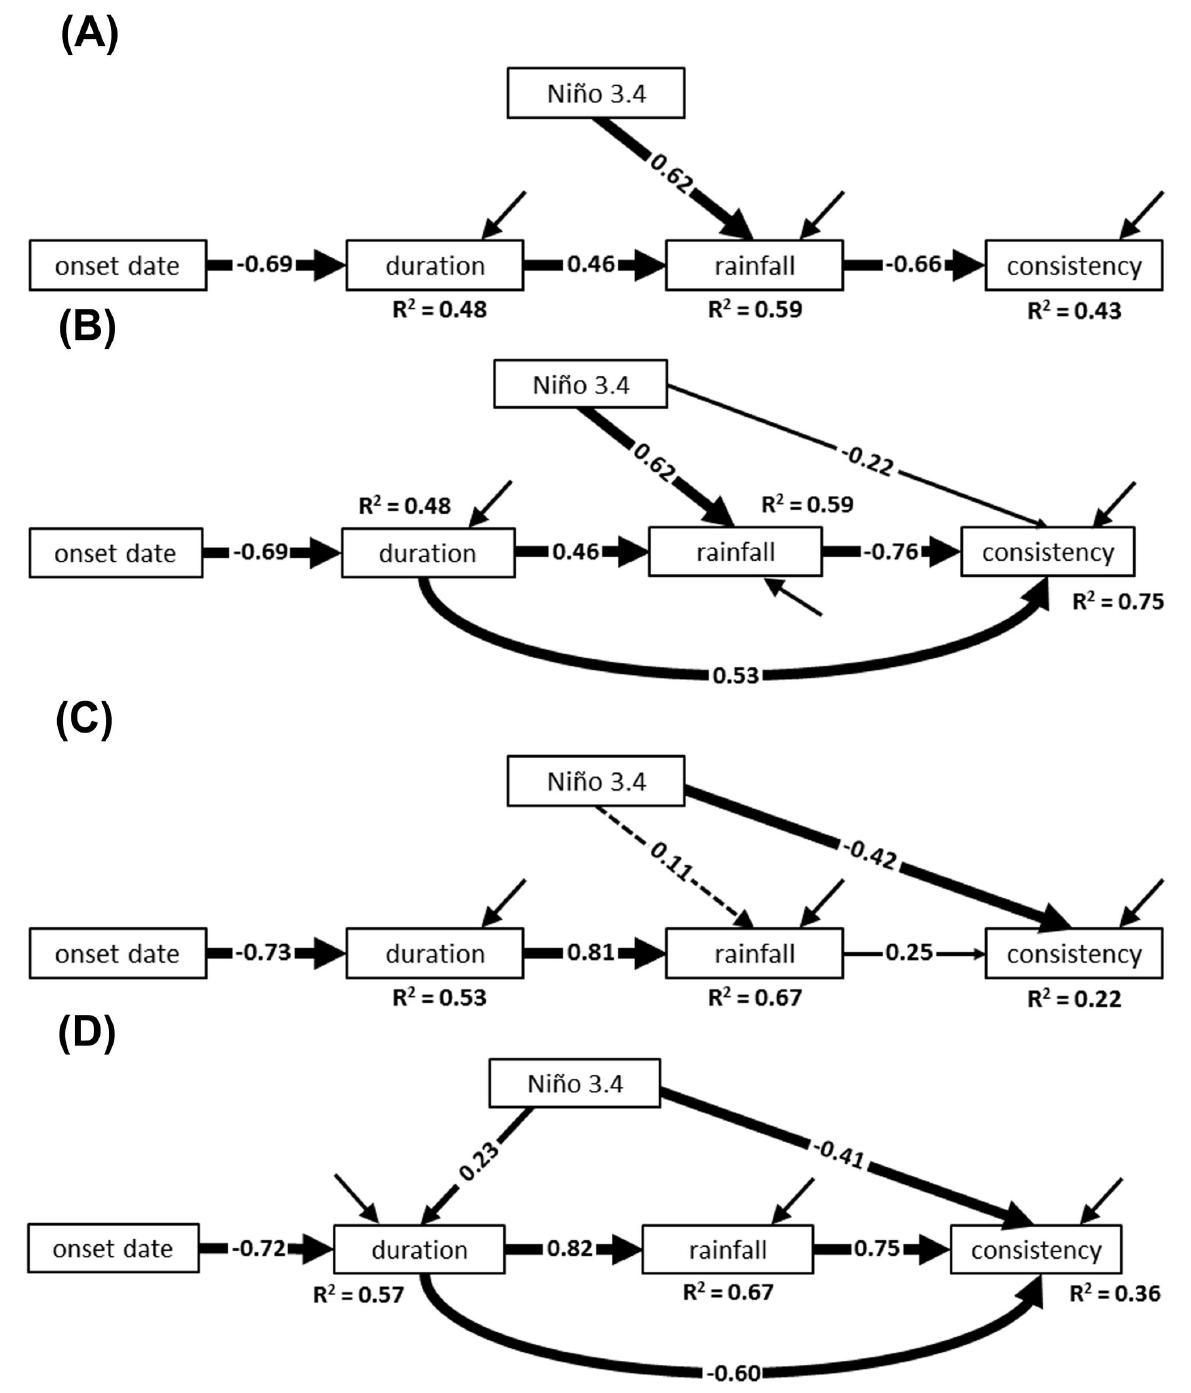
Figure 3. Structural equation models describing relationships among ENSO and seasonal characteristics for the two seasons. Models include (A) our starting, theory-driven model for the dry season (BCC = 65.6; χ 2 = 45.3, df = 6, p < 0.001), (B) the “best” exploratory model for the dry season according to BCC values (BCC = 39.7; χ 2 = 3.7, df = 4, p = 0.44), (C) our starting model for the wet season (BCC = 40.6; χ 2 = 18.2, df = 5, p = 0.003), and (D) the “best” model for the wet season (BCC = 28.8; χ 2 = 4.1, df = 4, p = 0.40). Paths are accompanied by numbers, which are standardized partial regression coefficients. The significance of these coefficients is shown with differently weighted lines (dashed = non-significant, thin = p ≤ 0.05, medium = p ≤ 0.01, and thick = p ≤ 0.001). Models use 58 years of climate data collected for the Avon, Park Air Force Range, south-central Florida, USA (1950-2007). doi: 10.1371/journal.pone.0075946.g003 PLOS ONE |